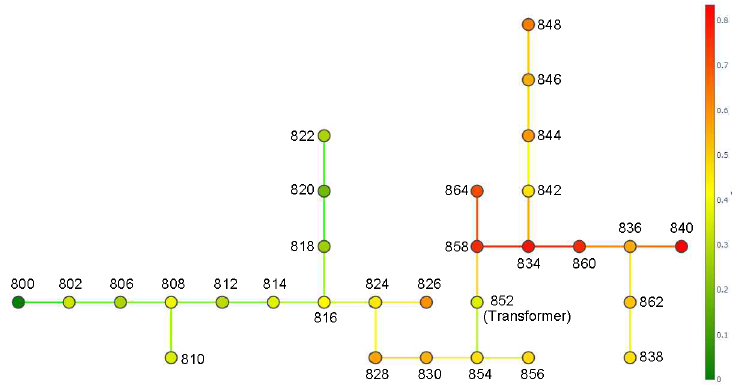
Figure 22. D function graphical representation for m = 0.5 and n = 0.5, corresponding to Base Case 3.